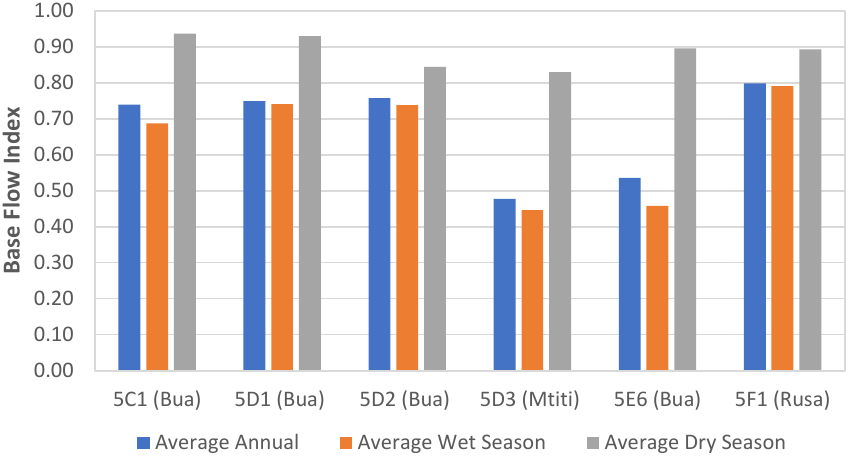
Figure 2. Results of annual and seasonal BFI analysis for the gauges in WRA 5 (graphical). Table 4. Results of annual and seasonal BFI analysis for the gauges in WRA 5 (tabular). Gauge ID (River)